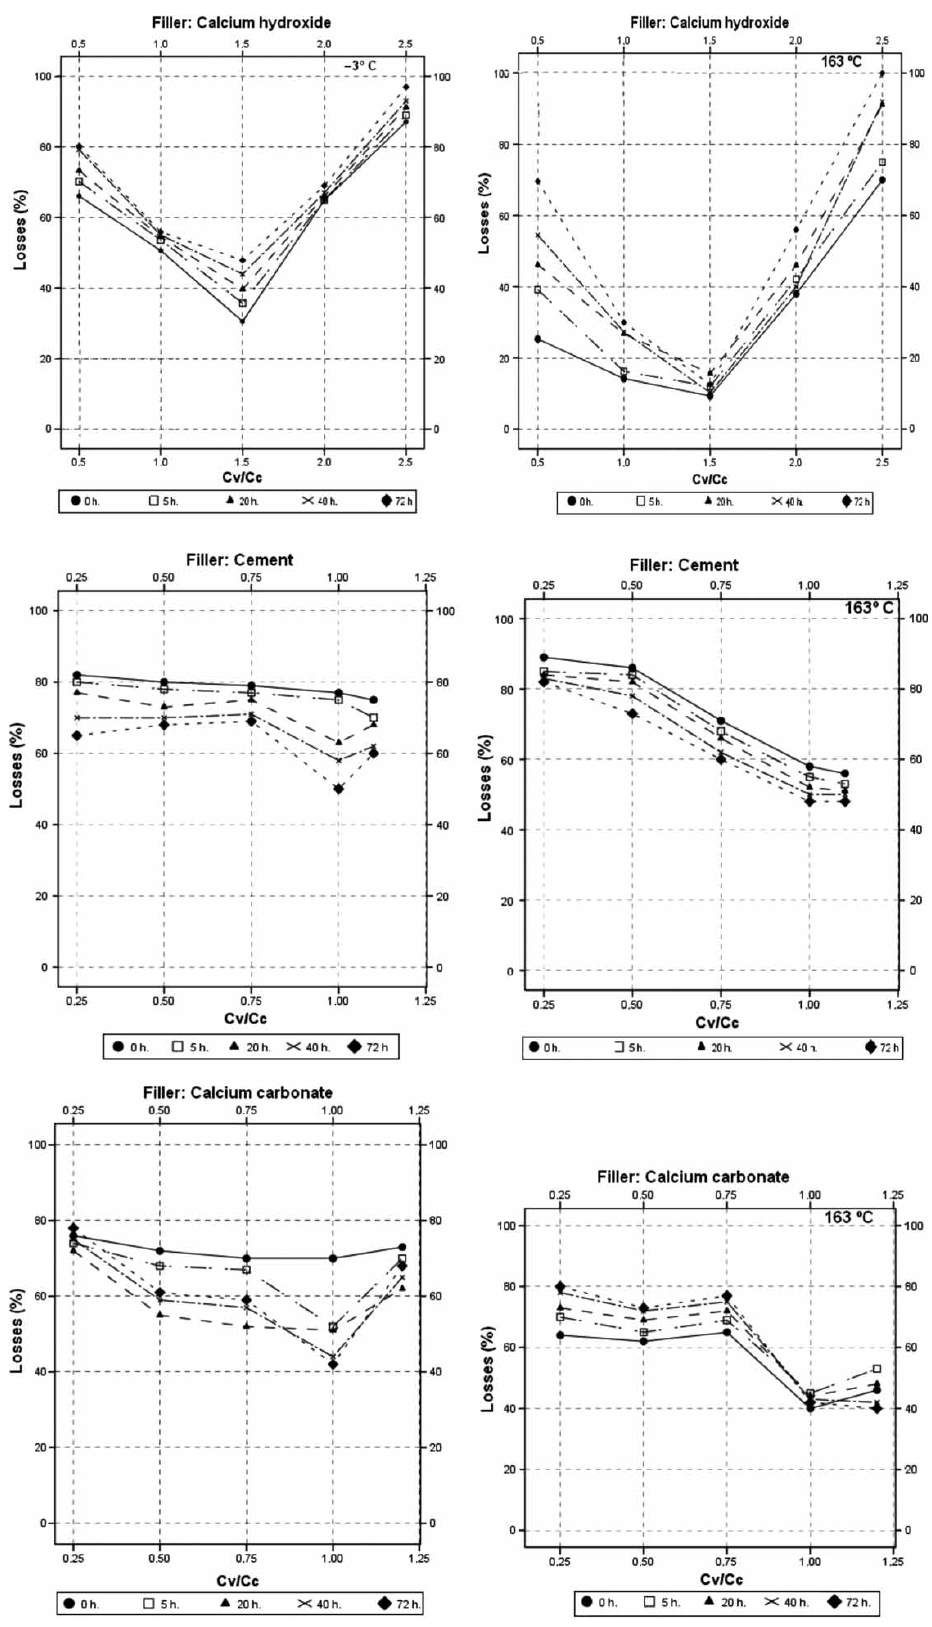
Fig. 5. Losses produced at (cid:1) 3 and 163 8 C for each